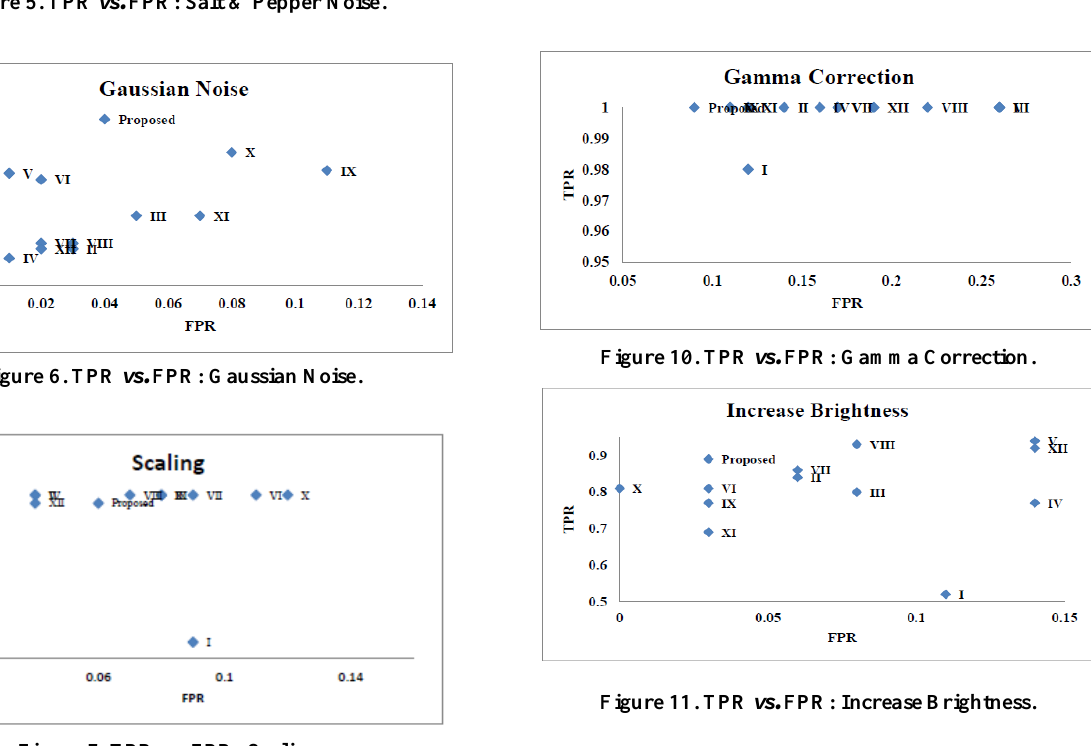
Figure 5. TPR vs. FPR: Salt & Pepper Noise.